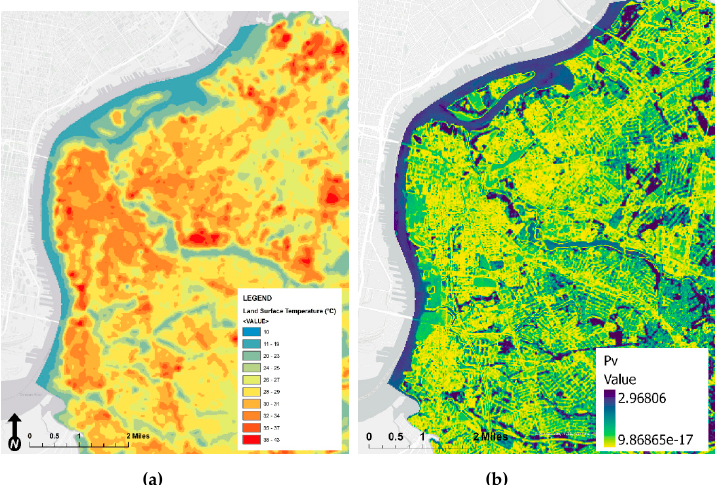
Figure 3. Environmental parameters mapped over Camden city: ( a ) land surface temperature (LST) in °C; ( b ) Proportional Vegetation (P v ).